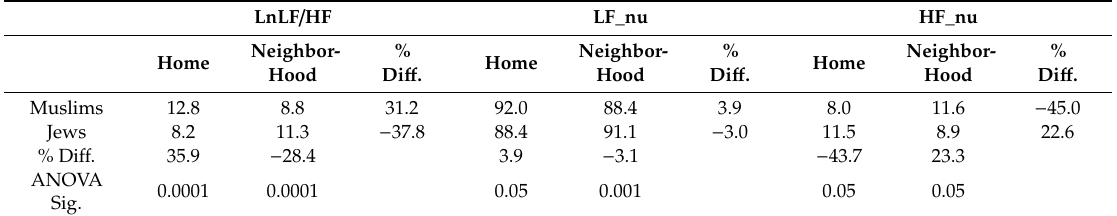
Table 1. Mean frequency domain heart rate variability (HRV) indices with children at home and outdoors without children by ethnicity: Muslim mothers ( n = 42), Jewish mothers ( n = 24).